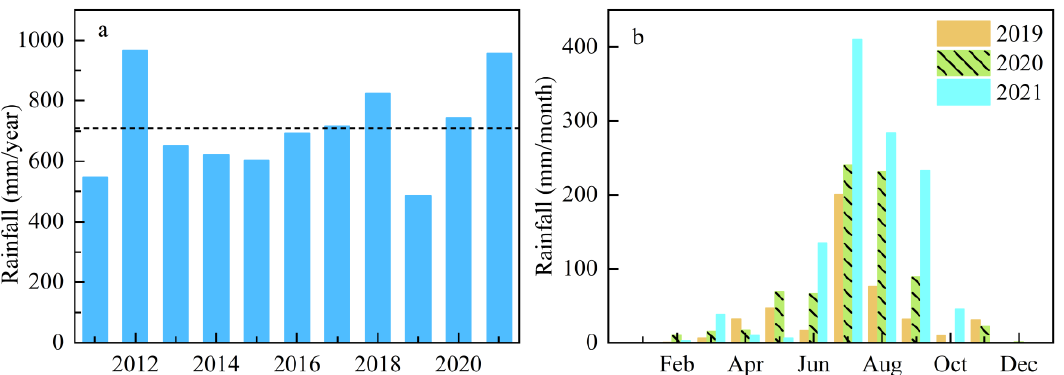
Figure 2. ( a ) The annual rainfall of the study area from 2011 to 2021. Black dashed line represented the mean rainfall of study area; ( b ) monthly rainfall from 2019 to 2021 at Yuqiao Reservoir station.